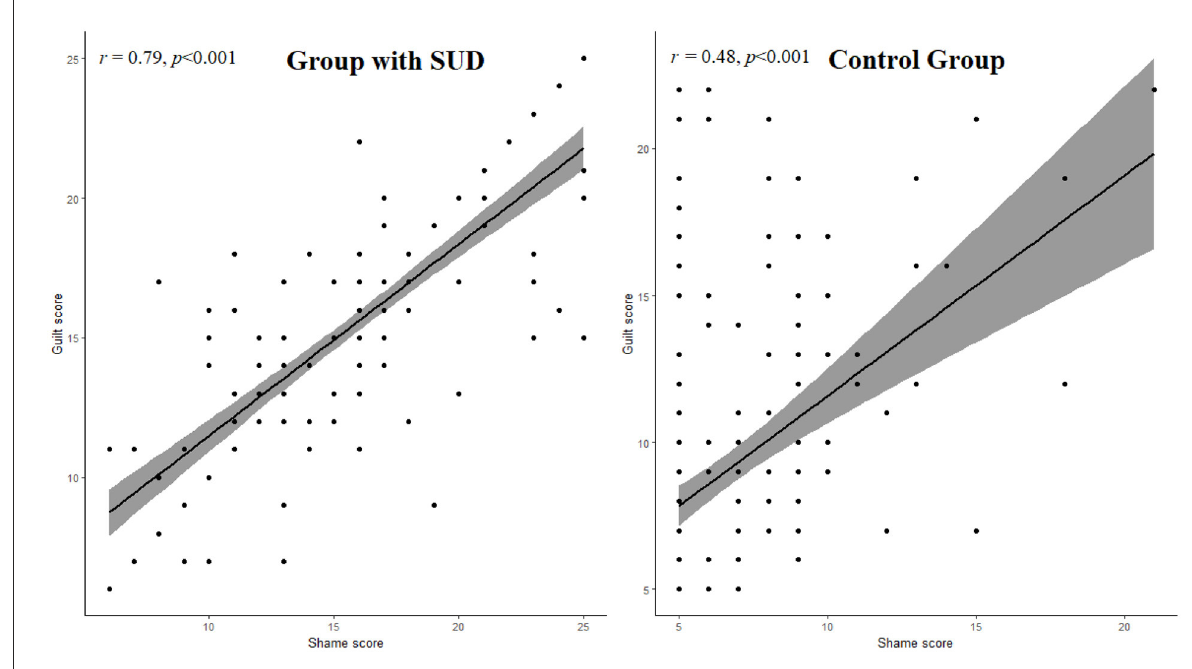
FIGURE1 Relationship between shame and guilt in the group with SUD and control group. r , Pearson correlation